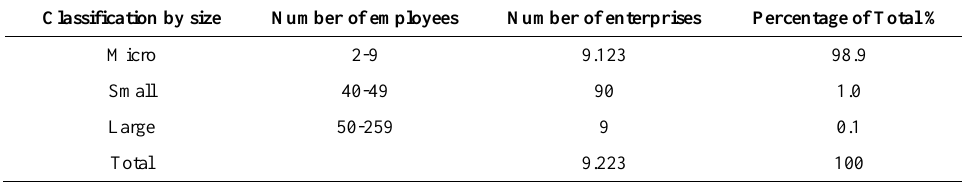
Table 1. Companies in Kosovo (Kosovo Agency of Statistics Report 2018 [31]